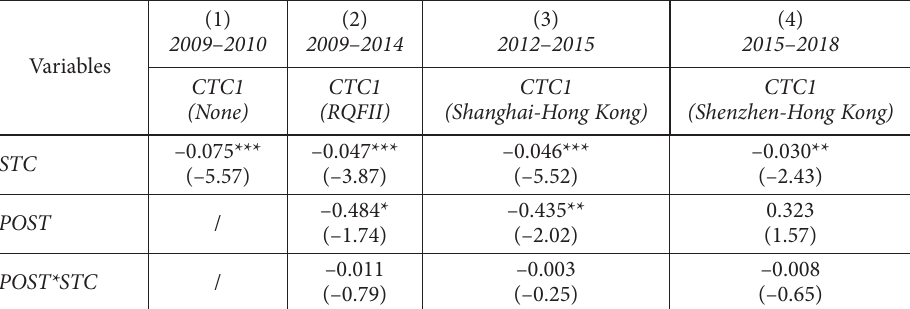
Table 8. Testing capital market liberalization’s effect on the substitution financing effect of suppliers’ trade credit on customers’ trade credit